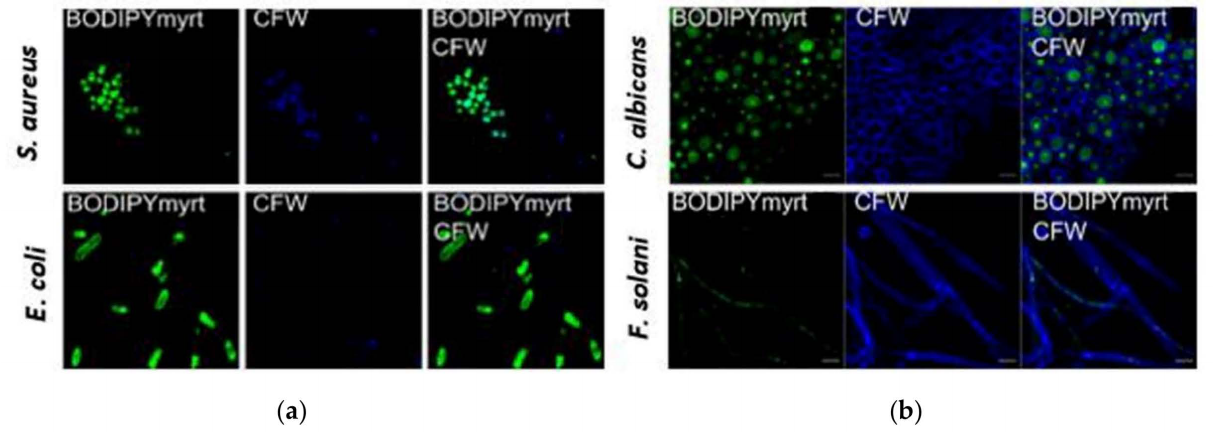
Figure 10. CLSM of bacterial cells ( a ) and fungal cells ( b ) stained by BODIPYmyrt and calcofluor- white (CFW). Scale bar is 10 µ m. Adapted from